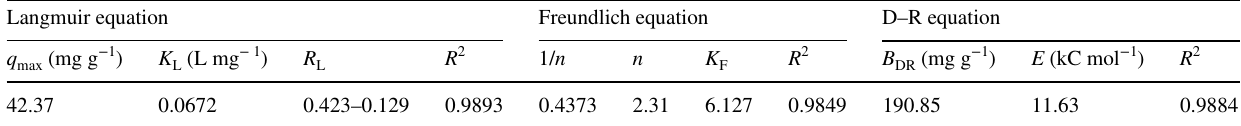
Table 3 Parameters of the Langmuir, Freundlich and D–R equations ( C Langmuir equation